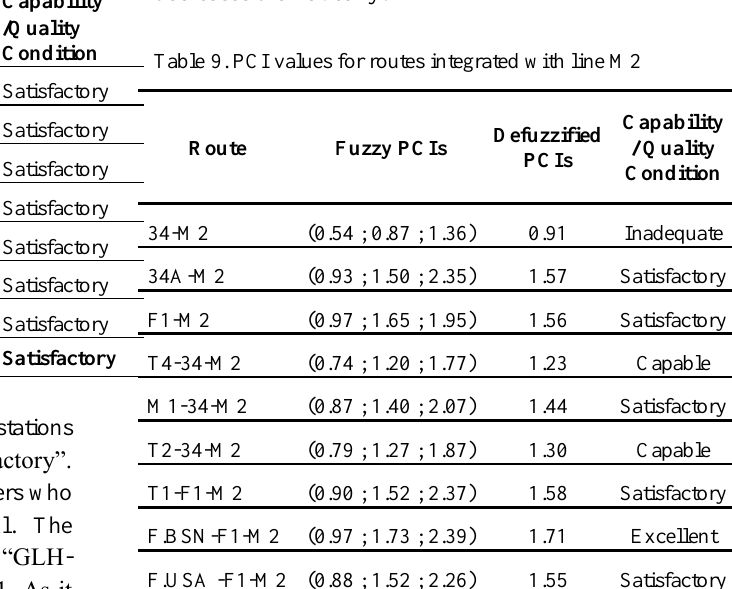
Table 9. PCI values for routes integrated with line M2